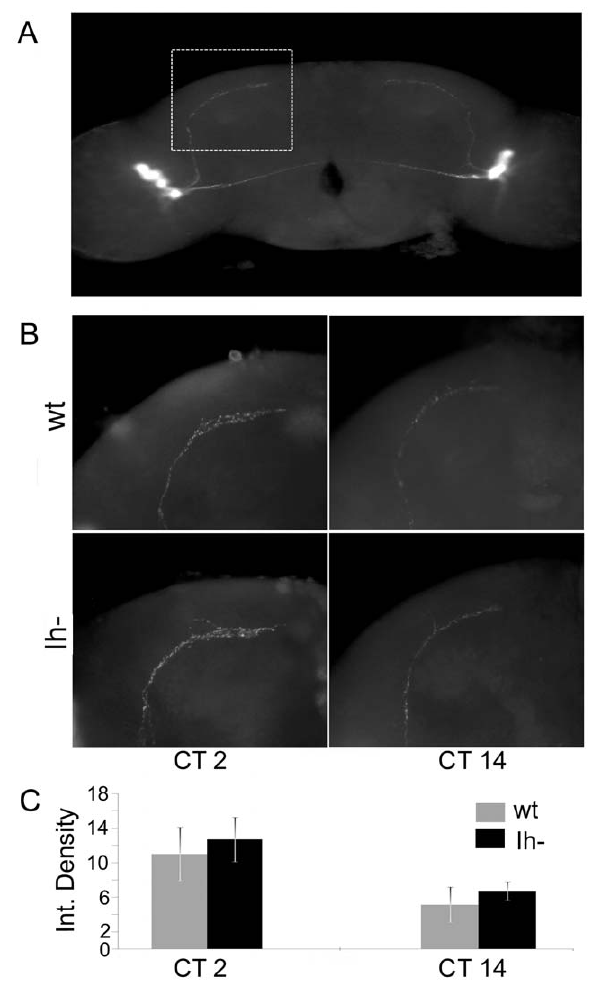
Figure 10. Lack of Ih current does not disrupt PDF clock output. Ih null mutants show normal circadian release of pigment dispersing factor (PDF) in DD conditions. (A) Anti-PDF staining of brains showing the LNv cells and their dorsal projections. Dotted line shows the area selected for analyses. (B) PDF immunostaining in the dorsal projections shows normal oscillation of this factor in wild type (wt) and Ih null mutants ( Ih 2 ), with high levels in the early day (CT2) and low levels in the early night (CT14). (C) Quantification of PDF immunoflorescence (Integrated Density) in wt and Ih 2 at CT2 and CT14 (Error bars indicate standard deviation) There are no differences between genotypes at any time point (t 13 = 2 1.121, p=0.283 for CT2; t 11 = 2 1.794, p=0.100 for